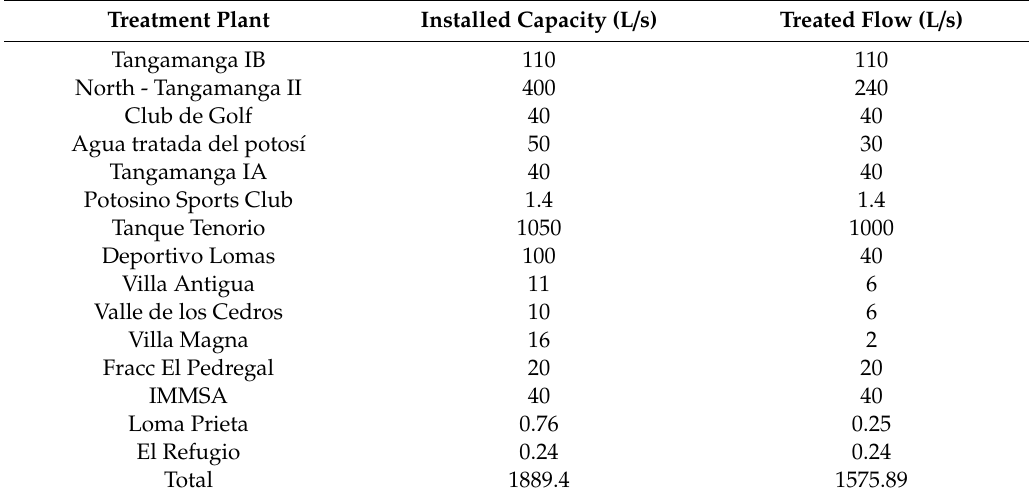
Table 2. The capacity of facilities for wastewater treatment.